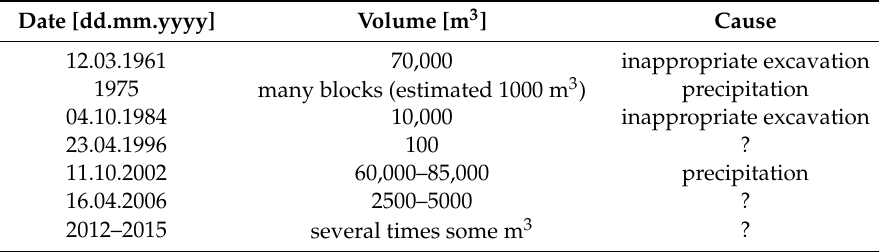
Table 1. Rockslides in the former quarry Spitz since 1961.